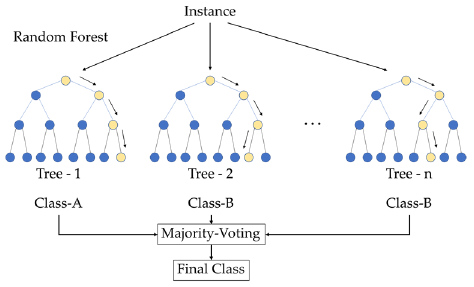
Figure 2. Typical Random Forest.